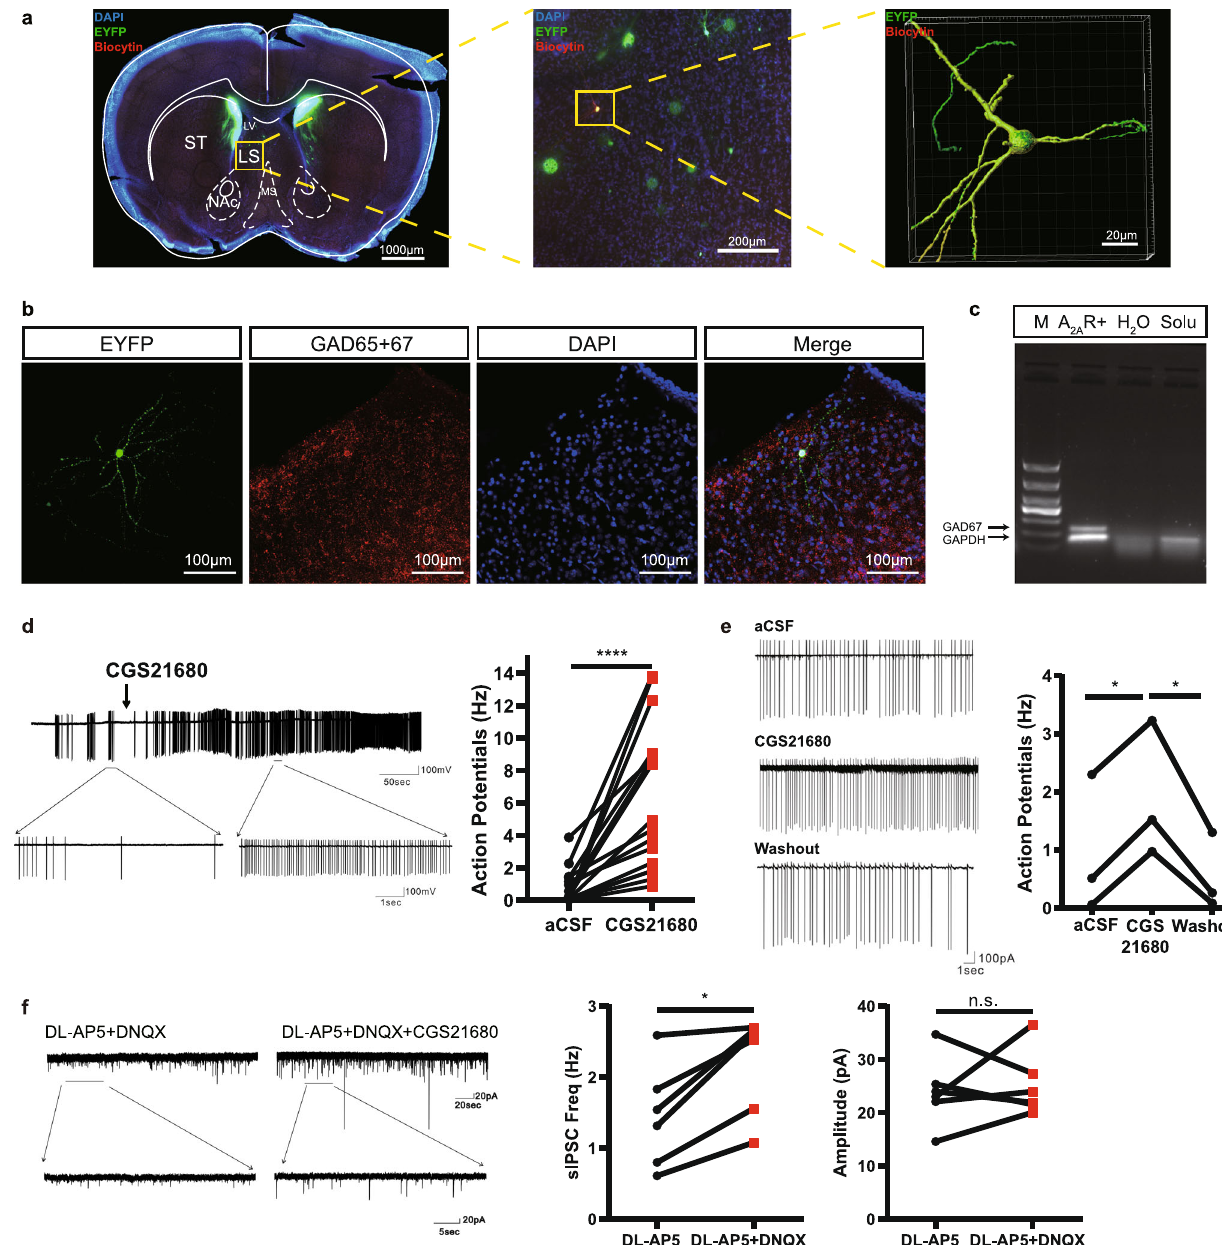
Fig. 2 | Activation of A 2A R in the lateral septum (LS) augments spiking fre- quency of LS-A 2A R + neurons with suppression of surrounding neurons. a Biocytin (red) in the intracellular solution diffused into the cells on brain slices from A 2A R-Cre mice injected with rAAV2/9-hSyn-DIO-EYFP into LS during the in vitro electrophysiological recordings. The recorded A 2A R + neurons (stained yellow) displayed long and numerous branches observed using confocal micro- scopy combined with 3D surface volume rendering. Scale bars: 1000/200/20 μ m. LV, lateral ventricle; MS, medial septum; NAc, Nucleus Accumbens core; ST, stria- tum. b Representative image from a 300 µ m slice after in vitro electrophysiology recording showing A 2A R + neurons (green)co-immunostained with anti-GAD65+67 antibody (red) in the LS. Nuclei are stained with DAPI in blue. Scale bar: 100 μ m. c Single cell RT-PCR analysiswith totalmRNAisolated from recordedcells showed thatallEYFP-positivecellswereGABAergicneurons.M,1000bpmarker;A 2A R + ,cell cytoplasm of LS-A 2A R + neuron; H 2 O, sterile double distilled water; solu, pipette solution. d Representativetraceandstatisticalgraphshowingthattheactivationof